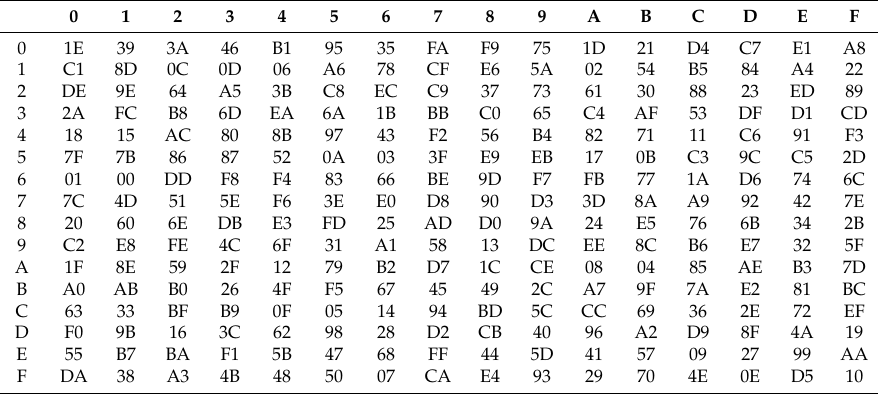
Table 4. Key and plaintext dependent S-BOX using KSA and PRGA enforced by Logistic Chaotic Maps (LCM) with key